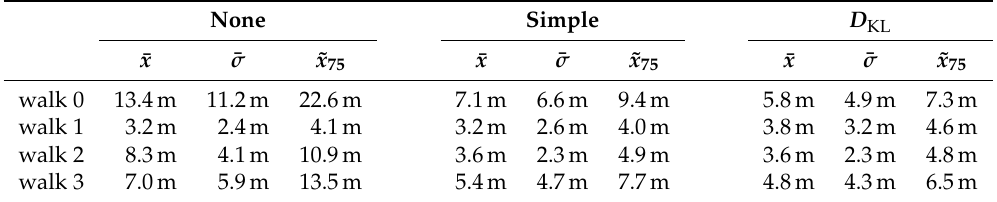
Overall localization results in meter using the different impoverishment